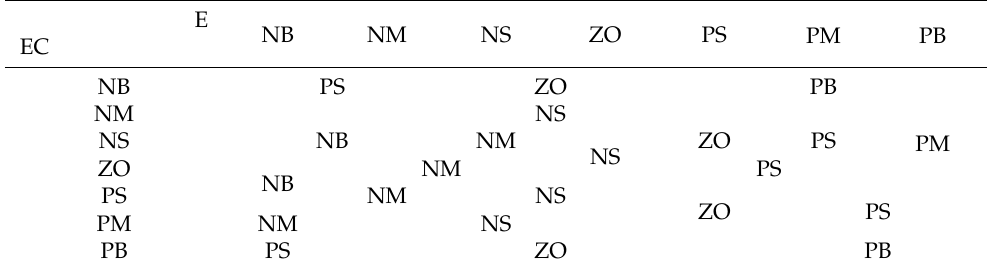
Table 3. ∆ K d fuzzy rule